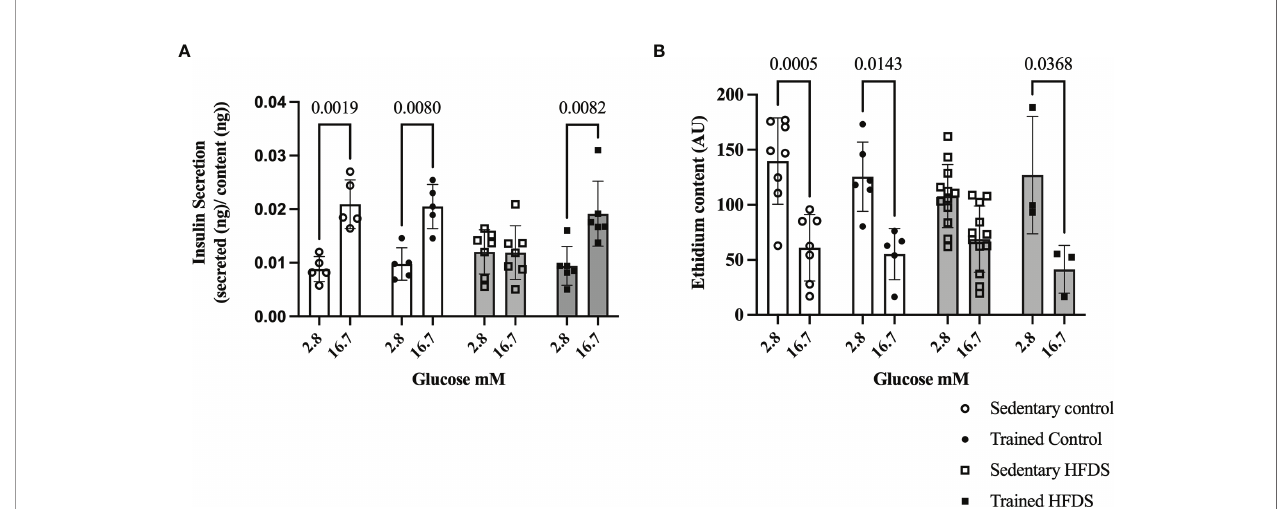
FIGURE 6 | Effects of eight weeks of exercise training and HFDS diet on pancreatic islets. (A) GSIS normalized for total insulin content. Glucose responsiveness (2.8 vs . 16.7mM) in C (P<0.0001), CTR (P<0.0001) and HFDSTR groups (P<0.0001). (B) Ethidium bromide content and average fl uorescence intensity by DHE in dispersed pancreatic islets after 1-hour of glucose stimulus (2.8 vs. 16.7mM). Glucose effect (2.8 vs . 16.7mM) in C, CTR and HFDSTR (P<0.001). Data are expressed as the mean ±